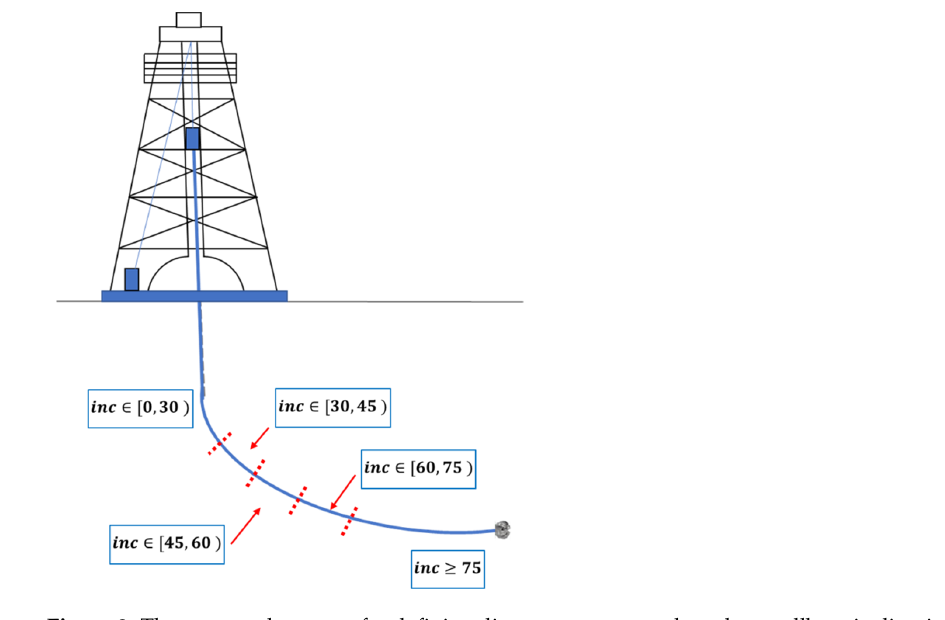
Figure 2. The proposed strategy for defining discrete state spaces based on wellbore inclination angles.